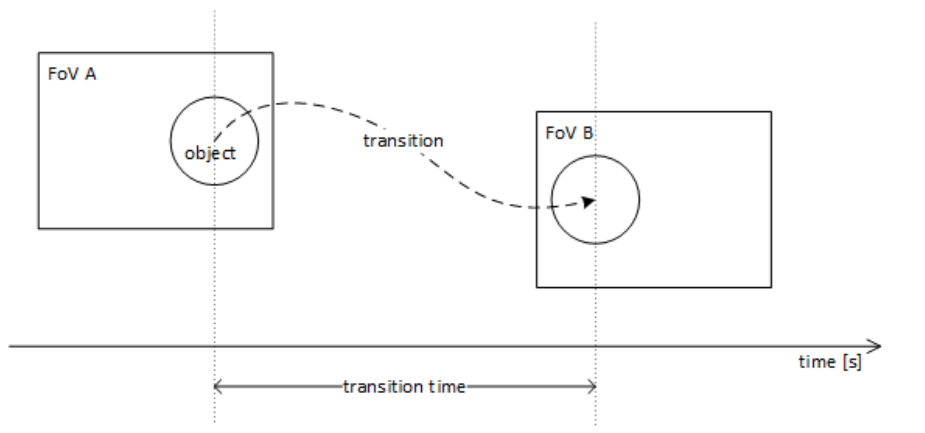
Figure 7. The transition time measurement.